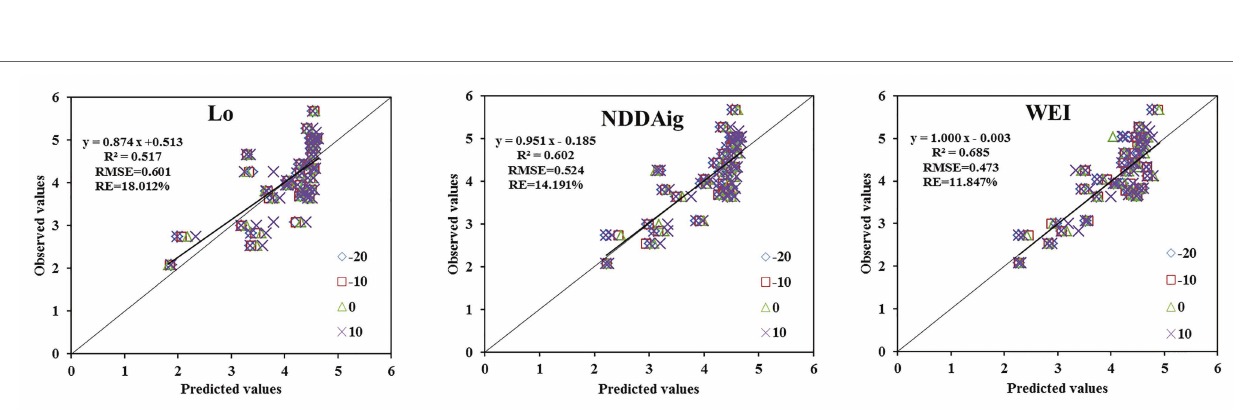
FIGURE 9 | Comparisons between predicted and measured WUE based on Lo, NDDAig, and WEI at a zenith angle of − 20 ° to +10 ° ( n =